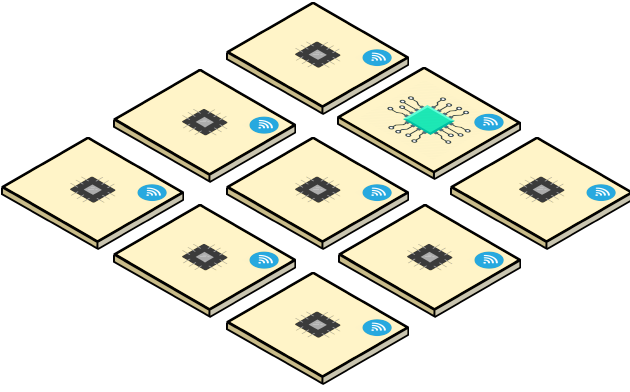
Figure 6. Wireless-enabled force